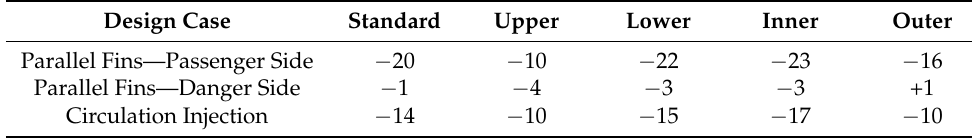
Table A3. Percentage change in slipstream velocity